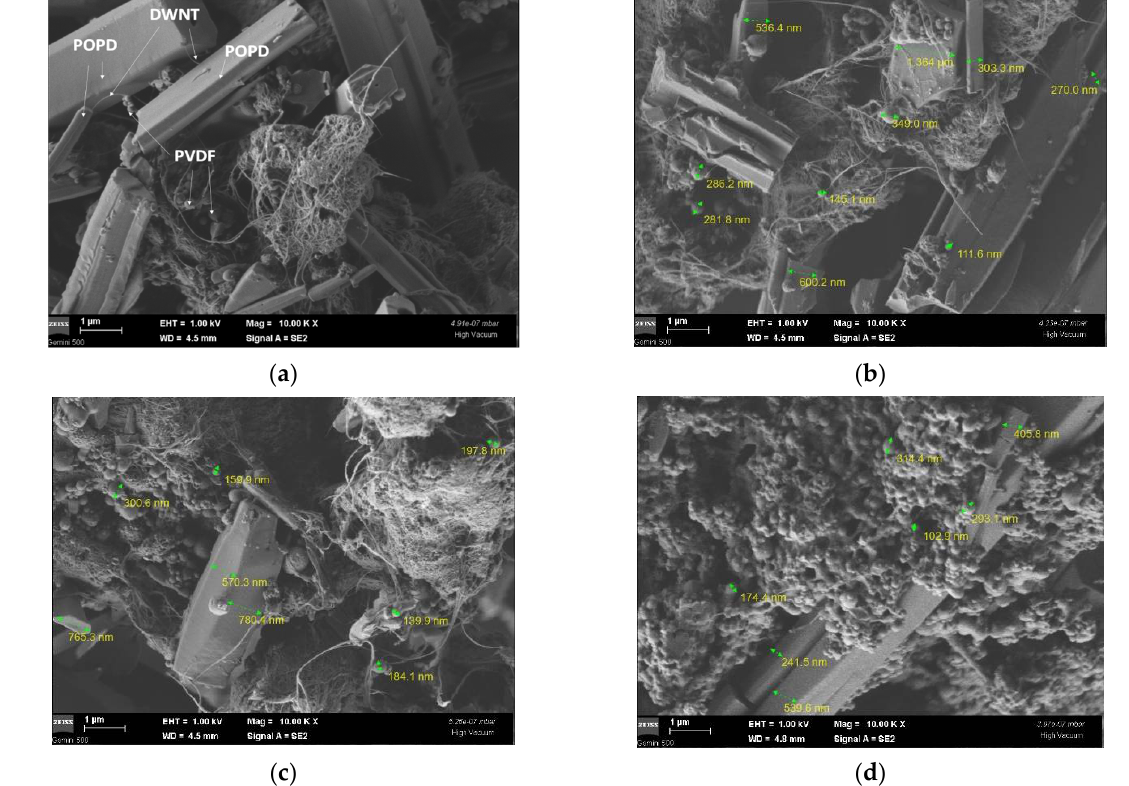
Figure 2. SEM images of the composites containing the POPD fiber like structures, PVDF spheres and DWNTs for which carbon nanotubes concentration is equal to 0.5 wt.% (the D sample, ( a )), 1 wt.% (the E sample, ( b )) and 2 wt.% (the F sample, ( c )). ( d ) shows the SEM image of composite based on the POPD-PVDF blends and DWNTs, when the carbon nanotubes concentration is equal to 1 wt.% (the G sample, ( d )).